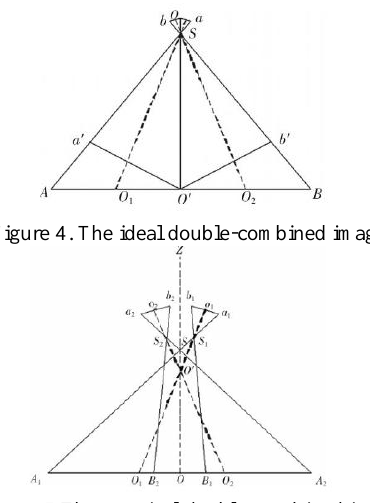
Figure 5 The practical double-combined